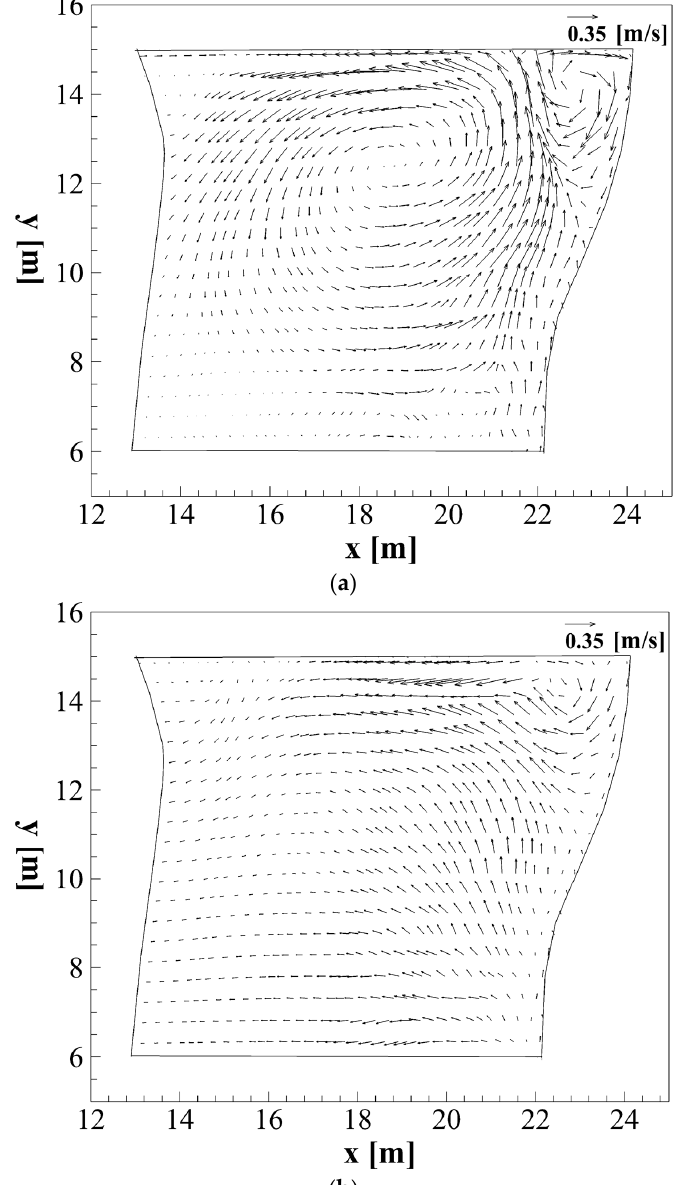
Figure 11. Test 4. Rip current. Plant view of the time average horizontal velocity components obtained using the proposed WTENO model: ( a ) close to the free surface; ( b ) close to the bottom (only one of every three vectors is drawn).